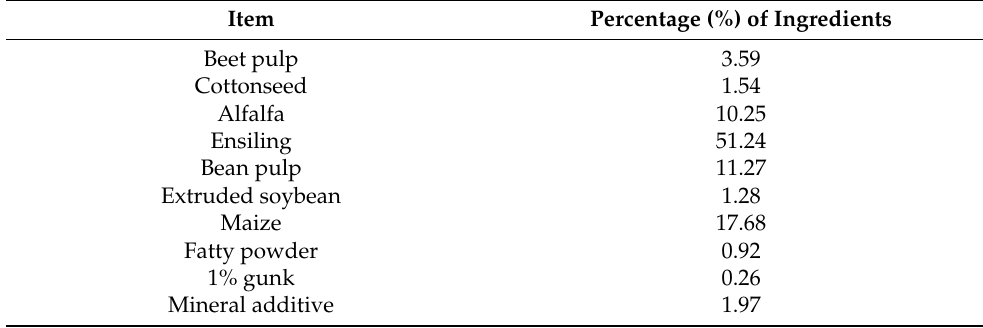
Table 1. Dietary composition of dairy